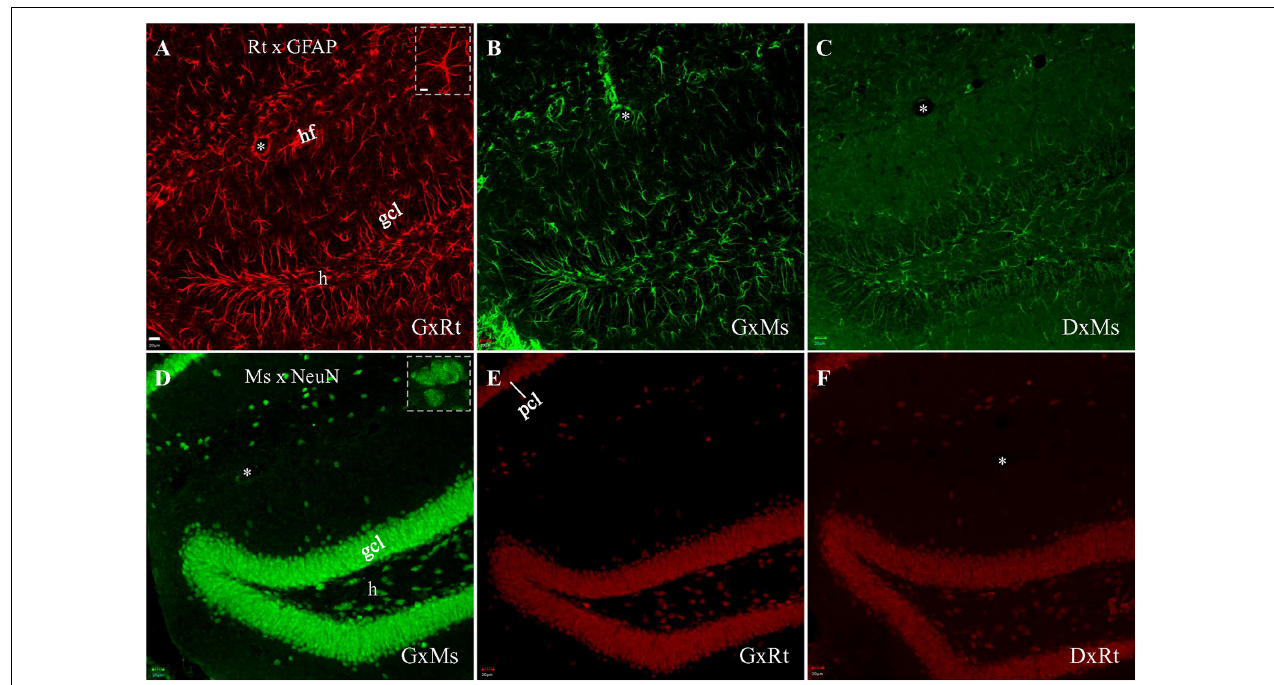
FIGURE 1 | Single immunofluorescent staining with rat anti-GFAP or mouse anti-NeuN primary, visualized with same-species or cross-species secondaries. Each stack of confocal photomicrographs acquired in 10- µ m-depth from a hippocampal slice with sequential scanning module. (A–C) Staining with rat anti-GFAP primary, visualized with goat anti-rat (A) , goat anti-mouse (B) , or donkey anti-mouse (C) secondary, respectively. Note the presence of numerous stained spiny astrocytic processes in (A) , and the absence of round, compact, neuron cell body-like staining. (B,C) Indicate unintended cross-species binding of anti-mouse secondary to rat primary, following the same staining pattern as in (A) . (D–F) Staining with mouse anti-NeuN primary, visualized with goat anti-mouse (D) , goat anti-rat (E) , or donkey anti-rat secondary (F) , respectively. Round compact neuronal nuclei and/or cell bodies are visible in (D) , and spiny astrocytic processes are absent. (E,F) Show unintended cross-species binding of anti-rat secondary to mouse primary. Higher magnification of specific GFAP-stained astrocytes or NeuN-stained neurons highlighted in ( Insets ) in (A,D) , respectively. DxMs/DxRt, donkey anti-mouse/donkey anti-rat secondary; gcl, granule cell layer; GxMs/GxRt, goat anti-mouse/goat anti-rat secondary; h, hilus; hf, hippocampal fissure; pcl, pyramidal cell layer. Asterisks indicating blood vessels in hf. Scale bars: 20 µ m in all panels, except for 10 µ m in ( Insets ).